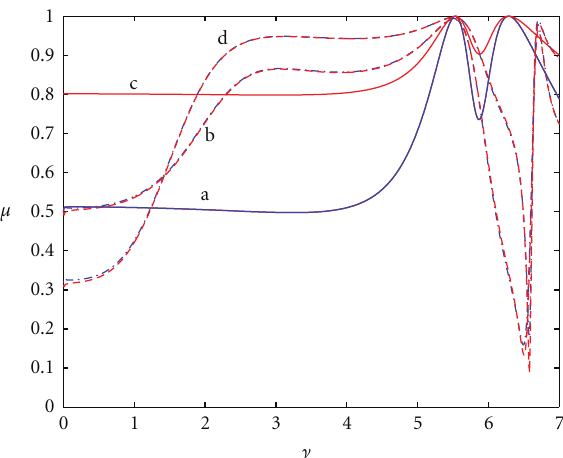
Figure 5: Degree of coherence along π /4 in focal plane of aplanatic lens with NA = 0 . 9 for uniformly polarized vortex beams with m